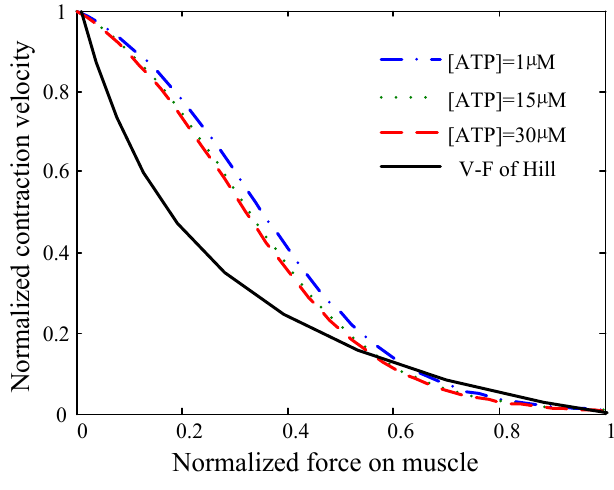
Figure 5. The normalized V-F